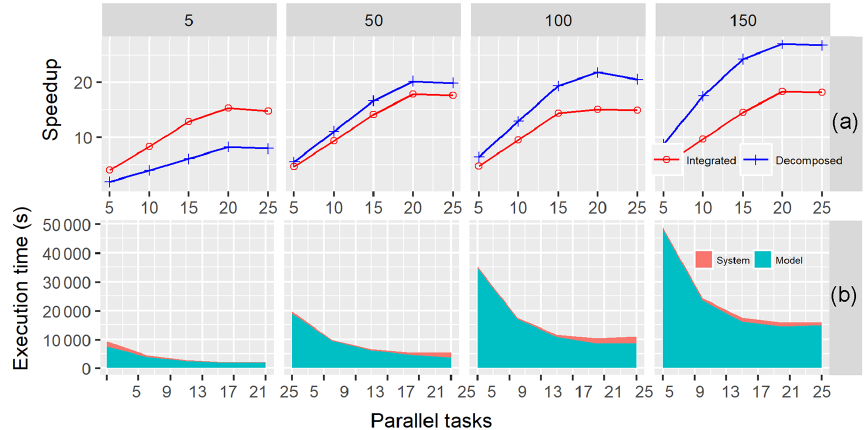
Figure 7. Speedups (a) and job execution times (b) for iterative model simulations on a Spark cluster versus the number of parallel tasks for the four synthetic hydrological